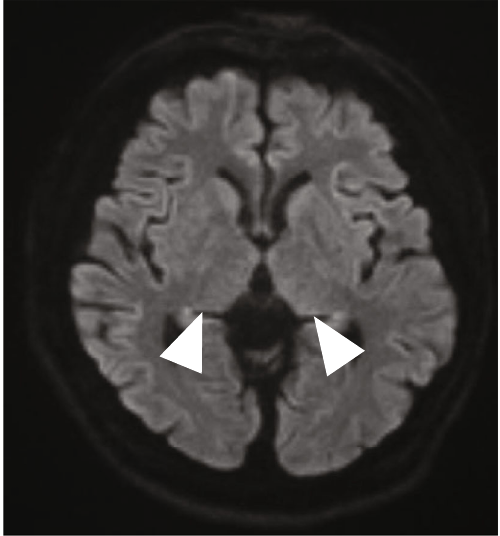
Figure 4: MRI on day 16 revealed no changes in the fi ndings except loss of hyperintensity on DWI (arrow). DWI: di ff usion- weighted image; MRI: magnetic resonance